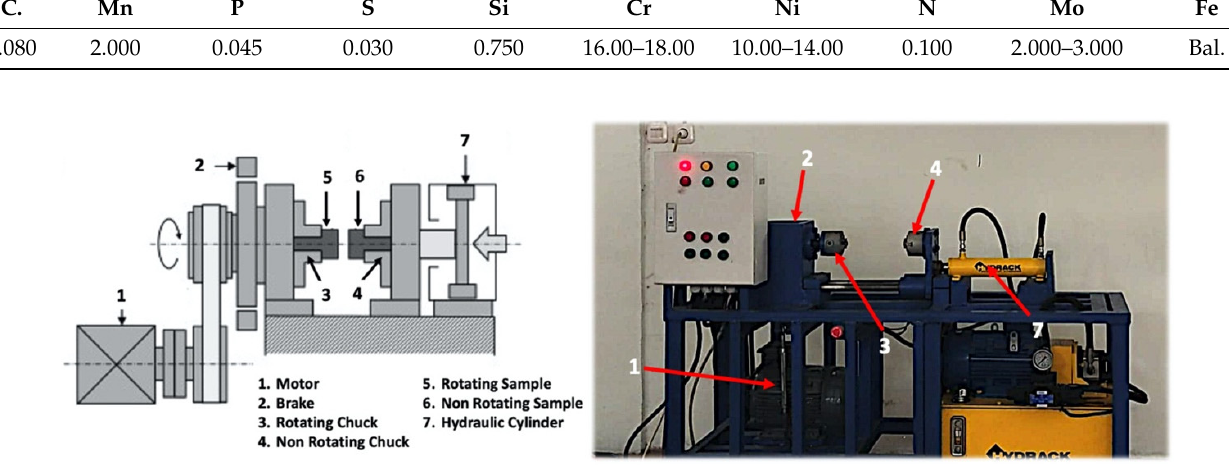
Figure 1. The image of experimental equipment and rotary friction welded SS 316-pure Zn. Table 1. Chemical composition of 316 stainless steel (wt.%).